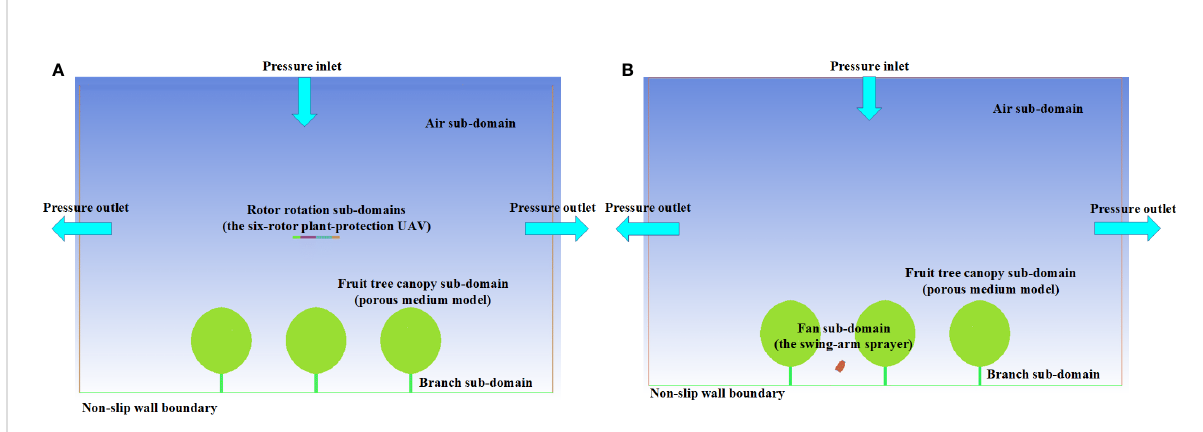
FIGURE 6 The model calculation area. (A) Plant-protection UAV model calculation area. (B) Swing-arm sprayer model calculation